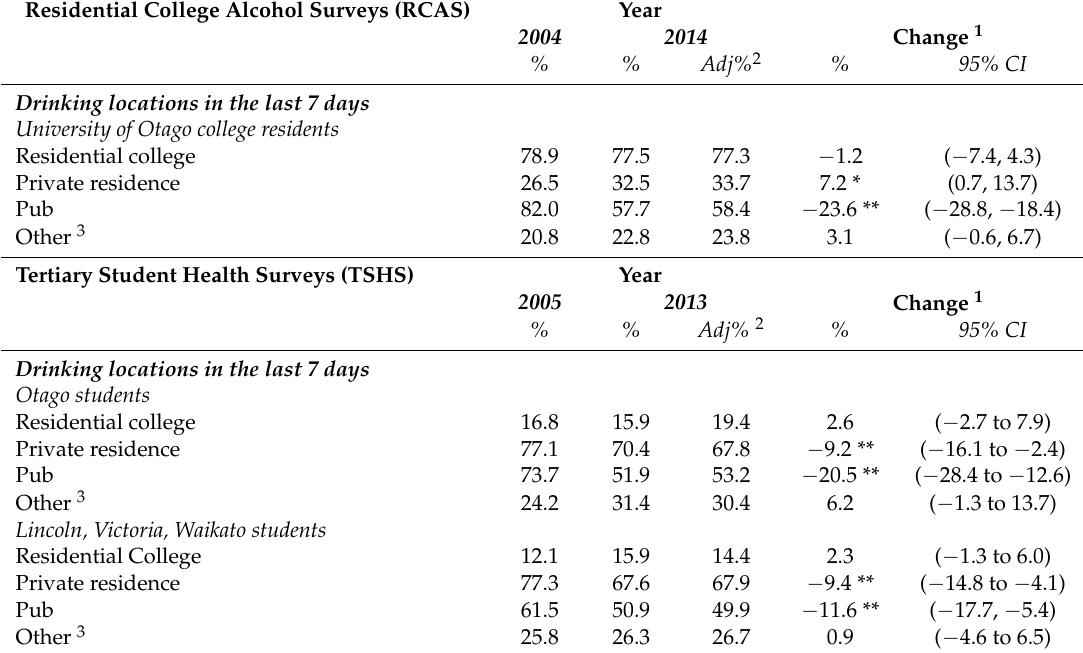
Table 4. Prevalence of drinking at residential colleges, private residences, on-licence premises and ‘other’ locations among students who drank alcohol in the preceding seven